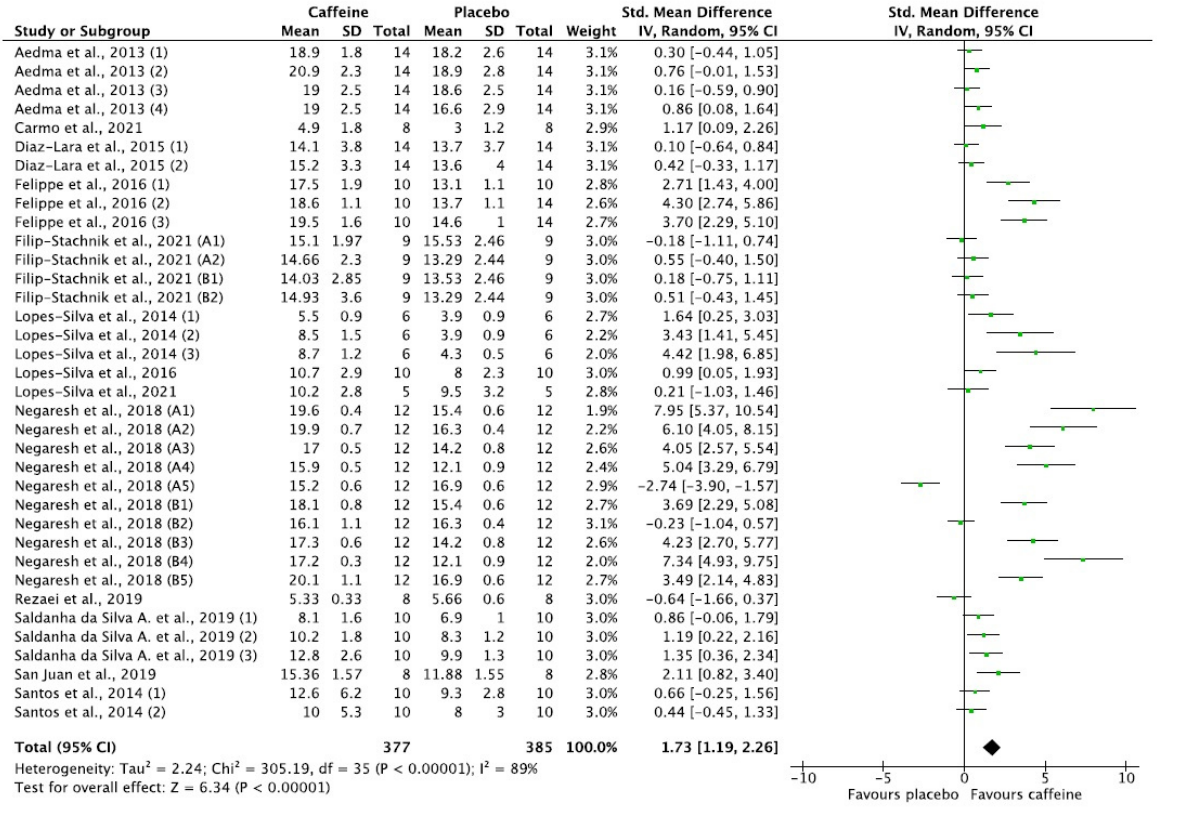
Figure 2. Forest plot results of a random effects meta-analysis for the placebo group compared with the experimental (caffeine) group the experimental (caffeine) group [26,27,29,30,45,46,47,48,50,54,55,56,57].